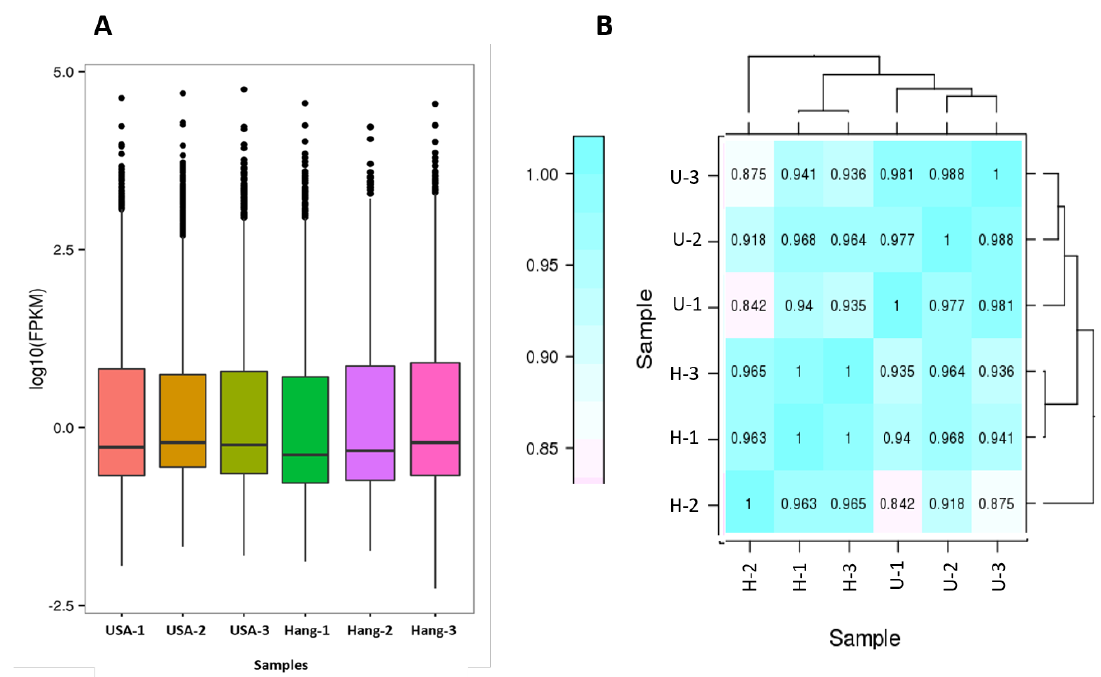
Figure 2. Overview of the transcriptome sequencing. ( A ) Gene expression profiles in the six libraries; ( B ) Heatmap clustering showing correlation among samples based on global expression profiles. U represents the USA fruit, while H represents the Hang fruit.